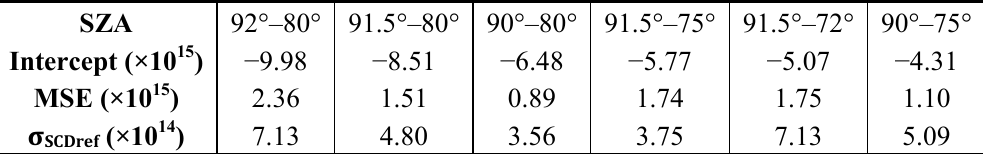
Table 3. Variation of intercept and errors resulted from